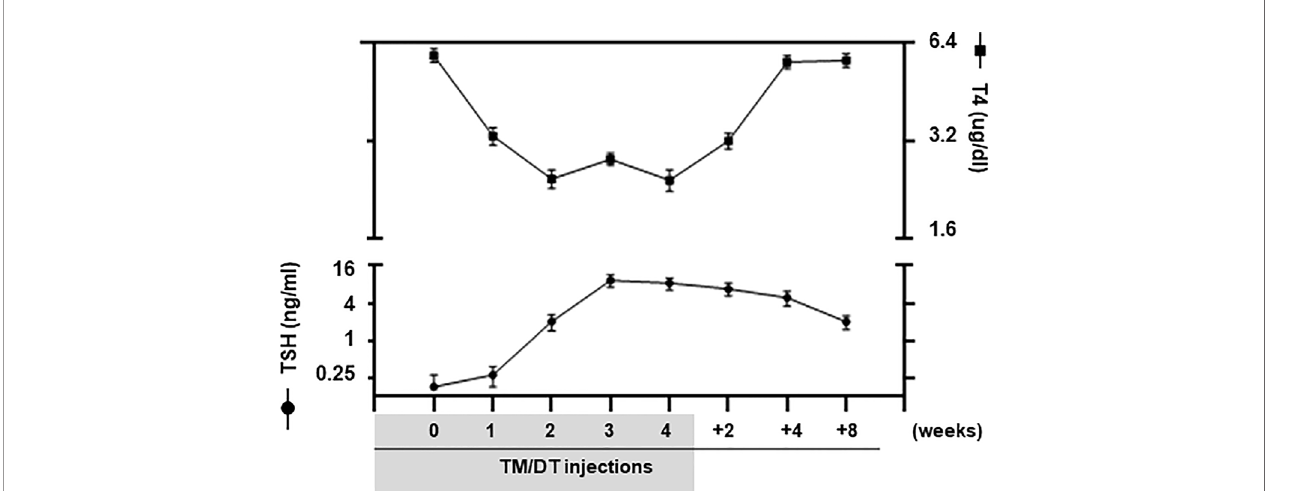
FIGURE 2 | Thyroid function of TPOCreER2/iDTR mice. Blood samples were collected from pre-treatment, TM/TD treated mice at 1, 2, 3, 4 weeks; and at after stopping TM/TD treatment at 2, 4, 8 weeks later, as indicated on the X-axis. Serum total T4 (Right Y-axis) and TSH (Left Y-axis) were detected using multiplex bead assays (Millipore) as described in Materials and Methods . In the treated mice we found that by 2 weeks their serum T 4 levels were markedly decreased after TM/DT administration and, at the same time, TSH levels had increased compatible with a signi fi cant degree of thyroid failure. Furthermore, after fi nishing 4 weeks of treatment, the thyroid function of the hypothyroid mice soon markedly improved. Serum T 4 levels were restored to basal levels and in parallel TSH levels decreased although not yet back to normal at 8 weeks. Date are expressed as mean ± SD (n = 4 – 6). For comparison, TSHR KO mice (T4 0.30 ± 0.01 ug/dl; TSH 530.0 ± 45.0 ng/ml) and WT normal mice (T4 6.01 ± 0.06 ug/dl; TSH 0.25 ± 0.10 ng/ml) were used but not shown in the fi gure.